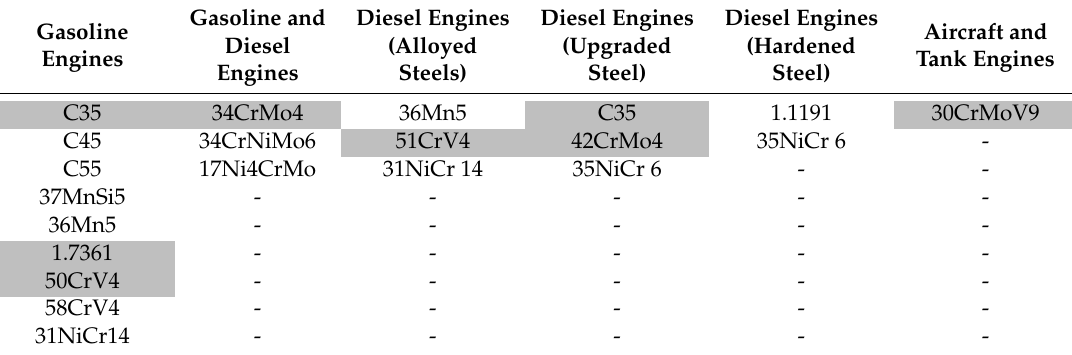
Table 1. Materials used for manufacturing of crankshafts.